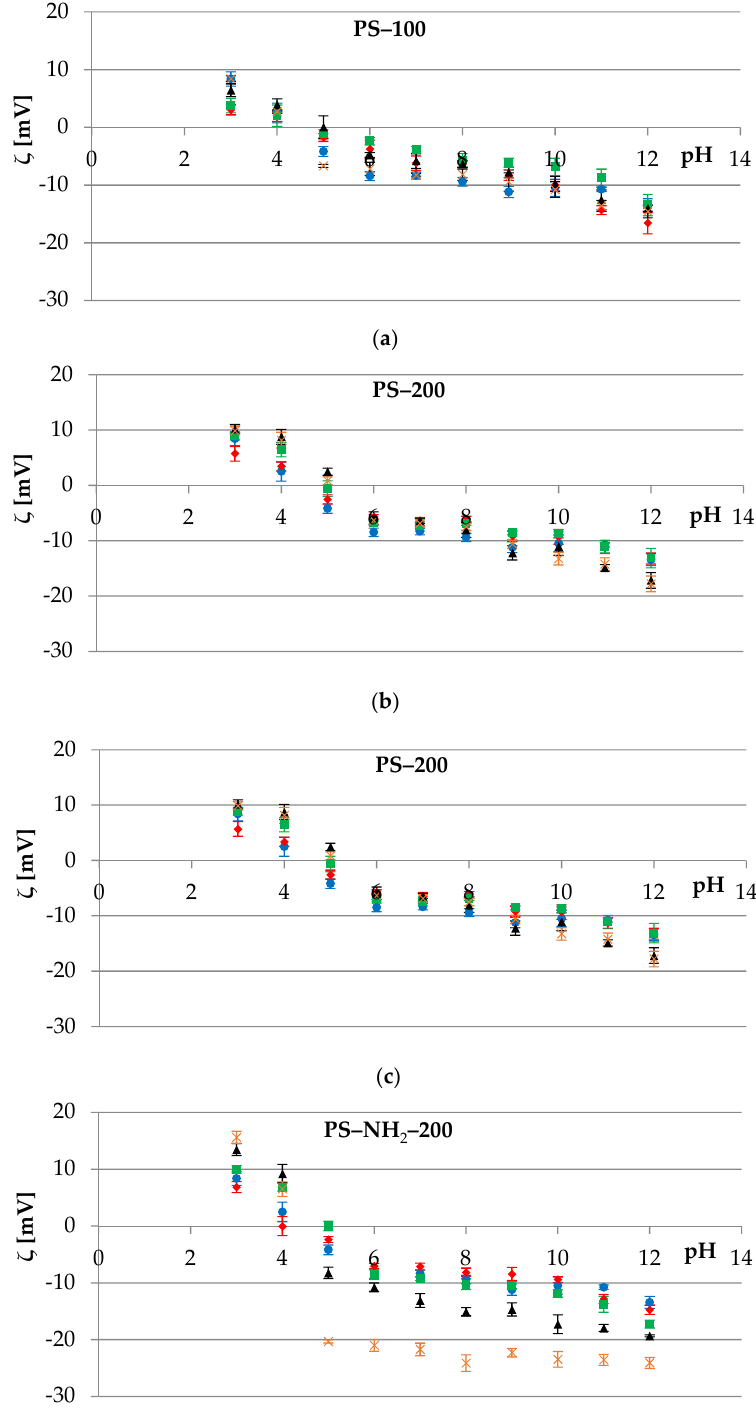
Figure 4. The zeta potential of the platelets’ cell membranes as a function of the pH of the electrolyte solution. Membranes untreated ( ● ) or treated with 0.002 ( ♦ ), 0.01 ( ■ ), 0.1 ( ▲ ), and 0.5 ( × ) mg/mL of various types of polystyrene polymer: ( a ) PS–100, ( b ) PS–200, ( c ) PS–NH 2 –100, and ( d ) PS–NH 2 –200.